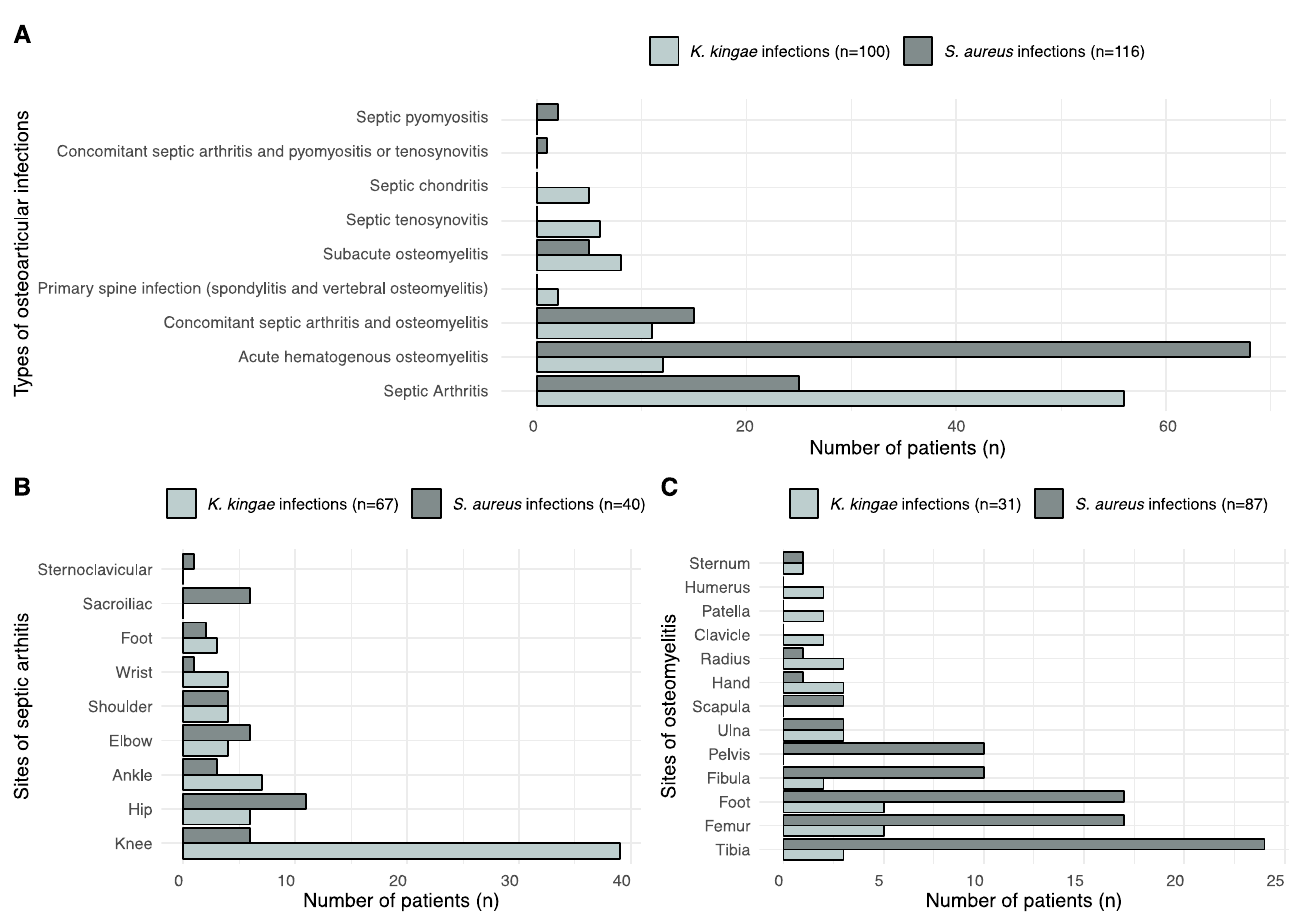
Figure 1. Age at infection for K. kingae and S. aureus . This chart shows that the incidence of K. kingae OAI is greater before 4 years old and almost disappears in older children.